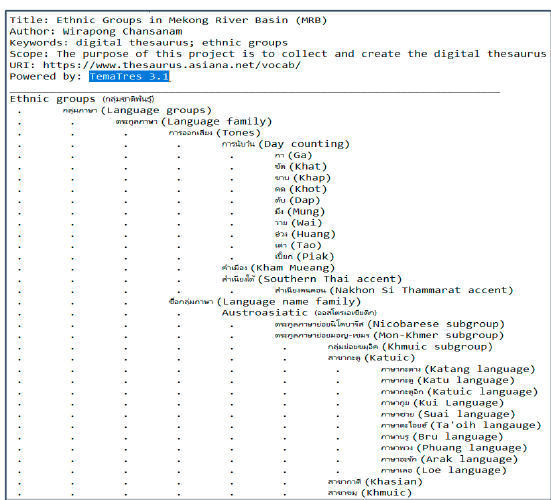
Figure 2. Example of groups of language groups of vocabularies in ethnic groups in the